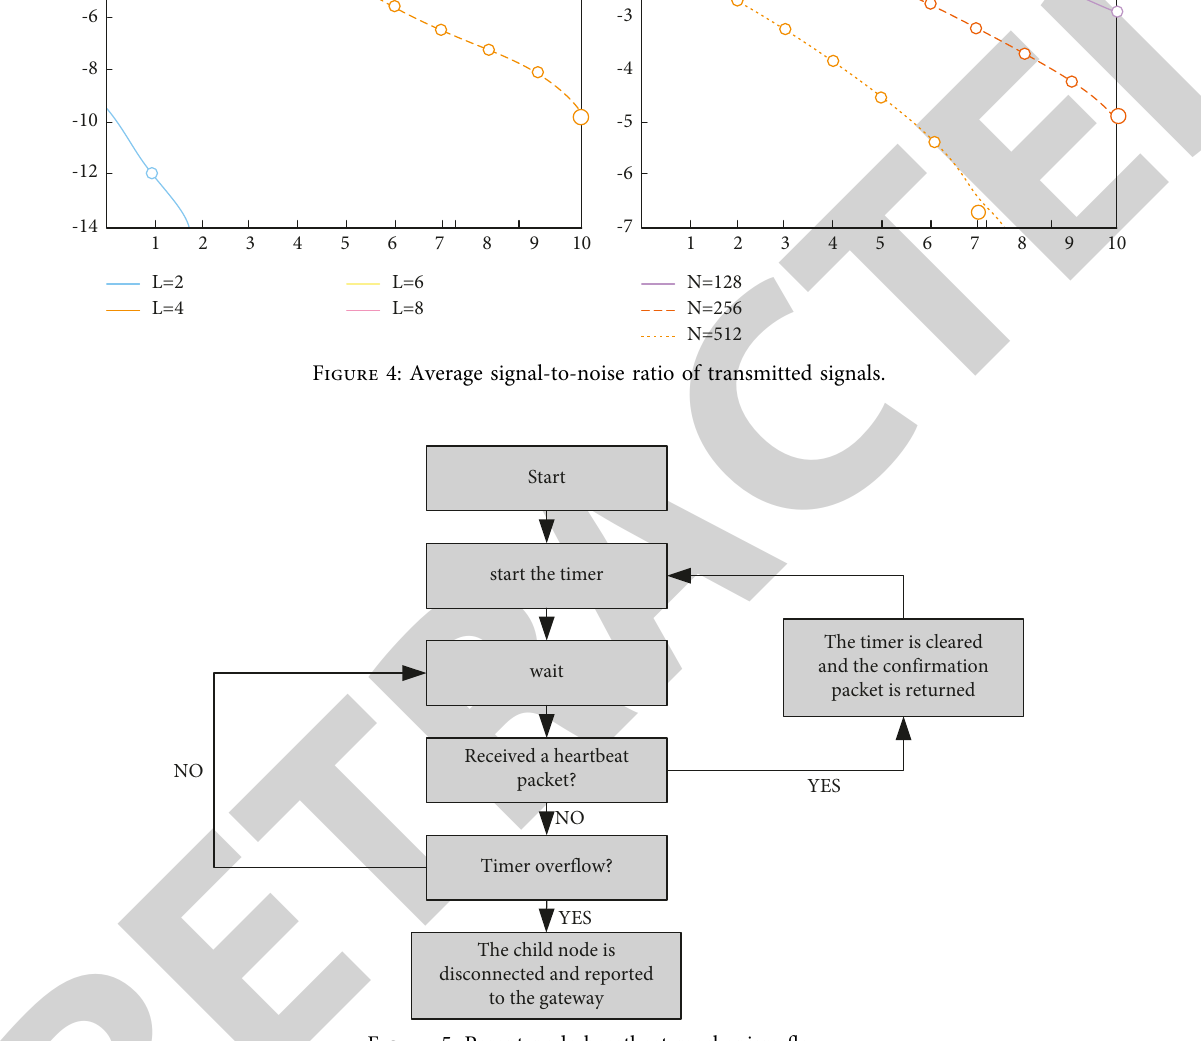
Figure 5: Parent node heartbeat mechanism